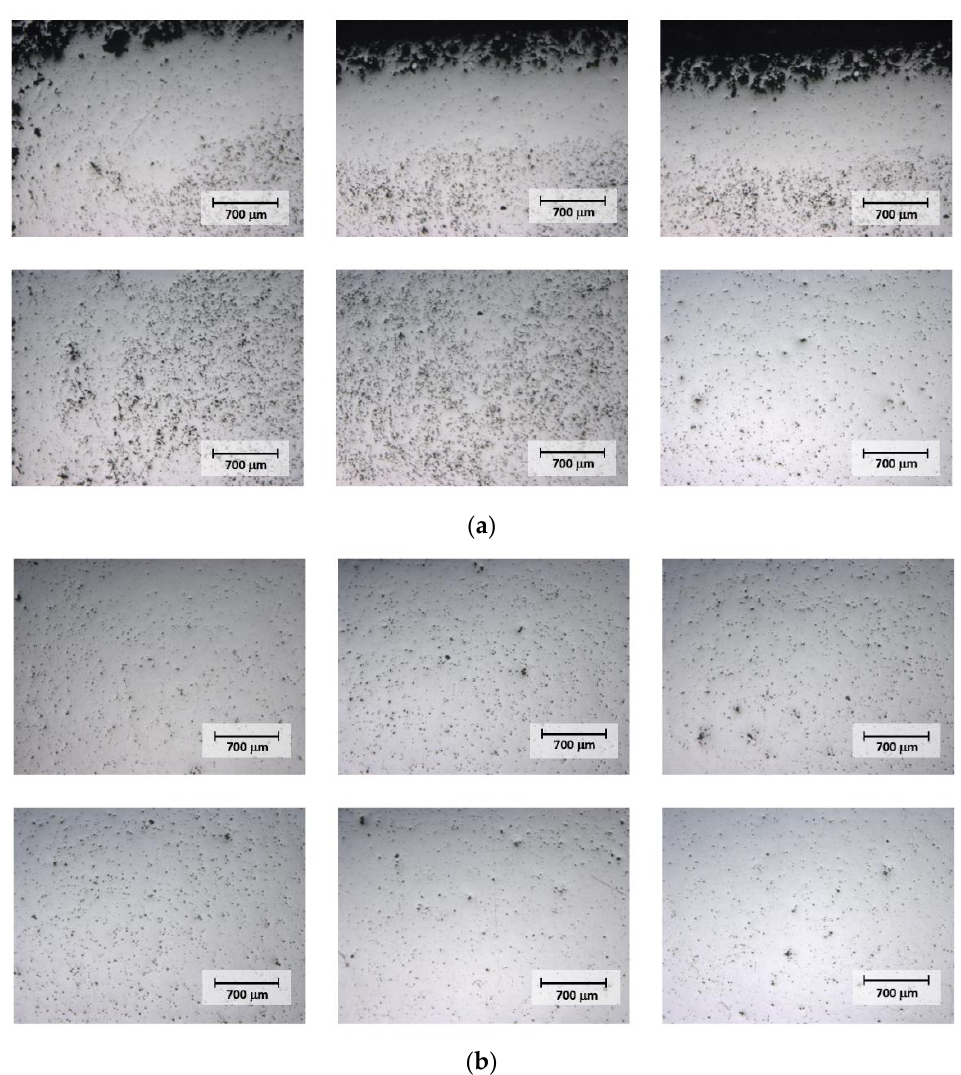
Figure 7. Porosity distribution in the upper-left quadrant of MF-ERS compacts processed with ( a ) 8 kA and 700 ms, and ( b ) 10 kA and 1000 ms.